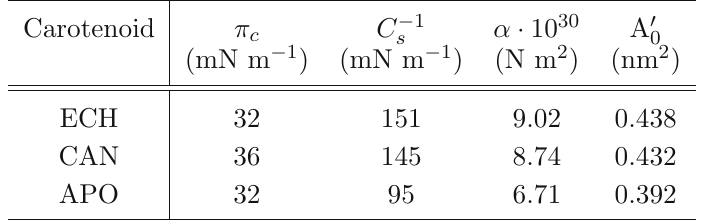
Table 1 Surface characteristics of the three carotenoids